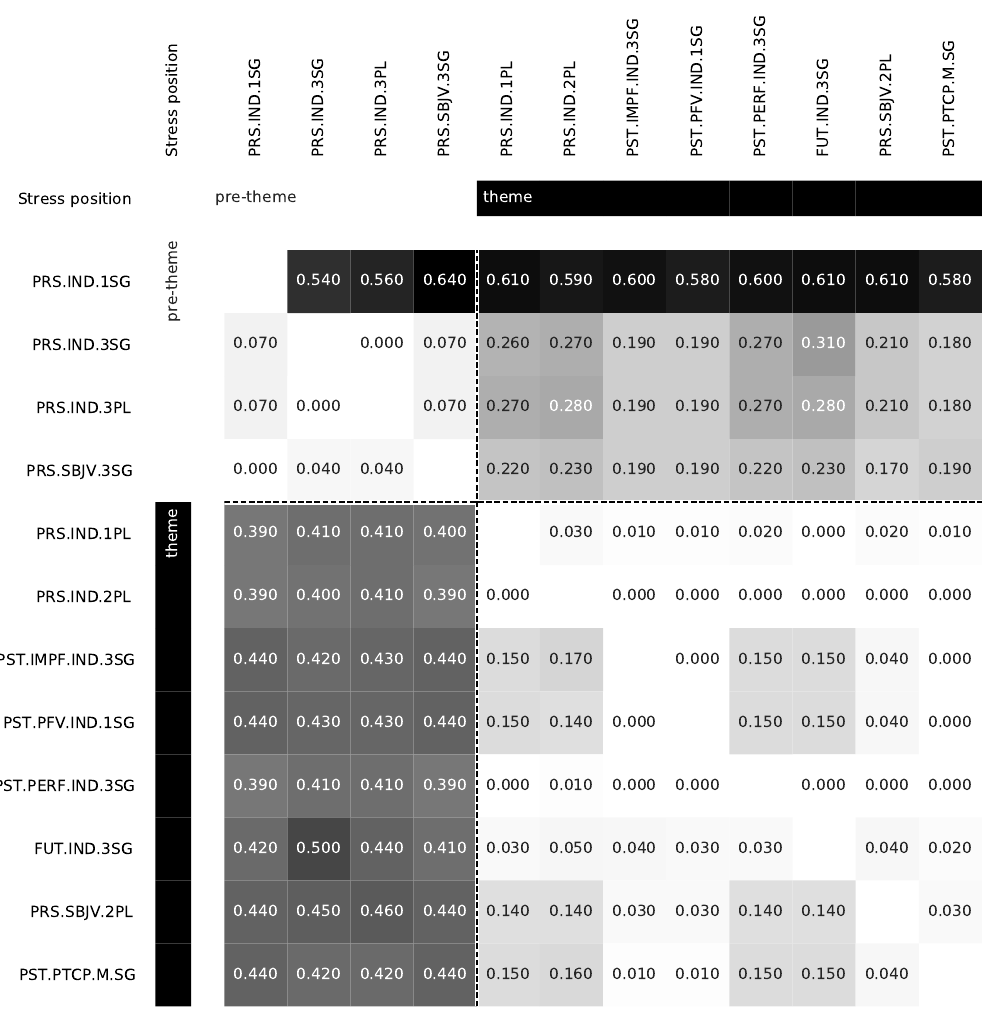
Figure 4: The influence of stress placement on